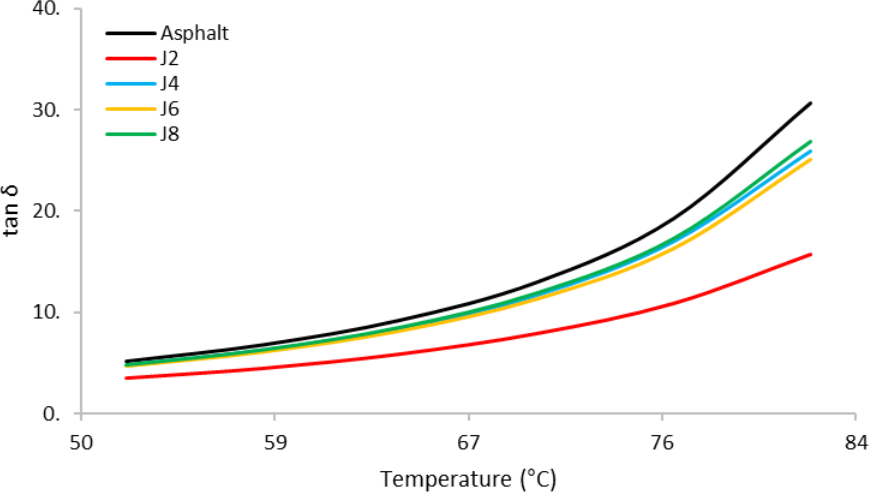
Figure 5. Isochronal plots of tan δ vs. temperature at 10 rad/s of asphalt modified by Jatropha curcas seed shell particles.